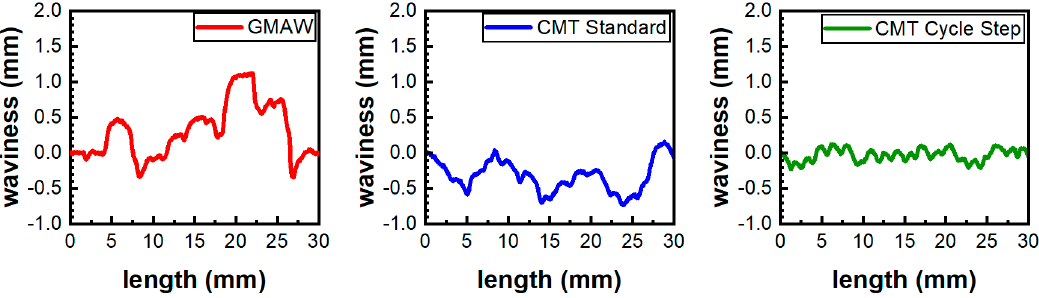
Figure 7. Surface laser scans along the build-up direction.